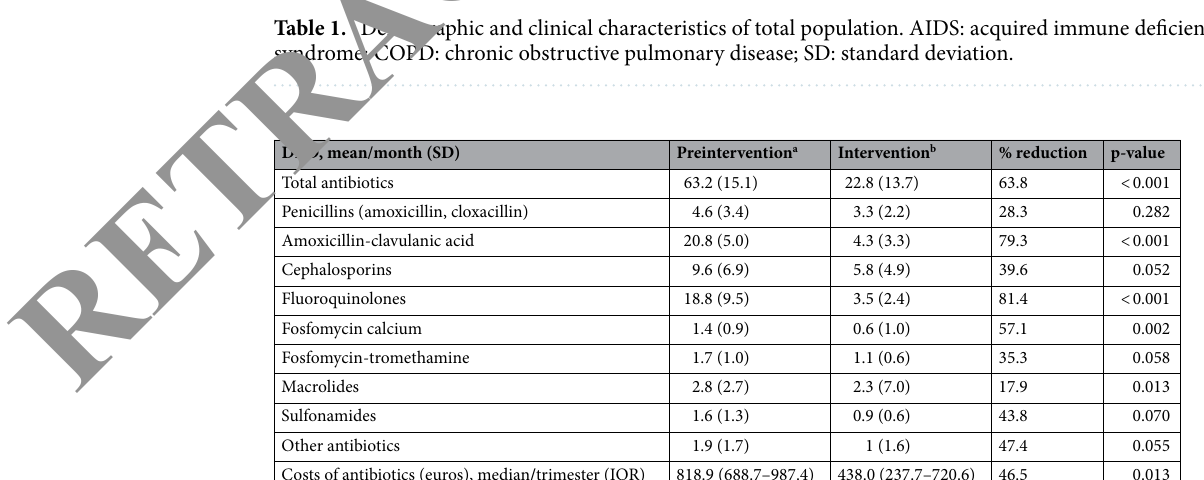
Table 2. Comparison of consumption and costs of antibiotics between periods. DRD: defined daily doses (DDD) per 1000 residents per day; IQR: interquartile range; SD: standard deviation. a January 1, 2018–June